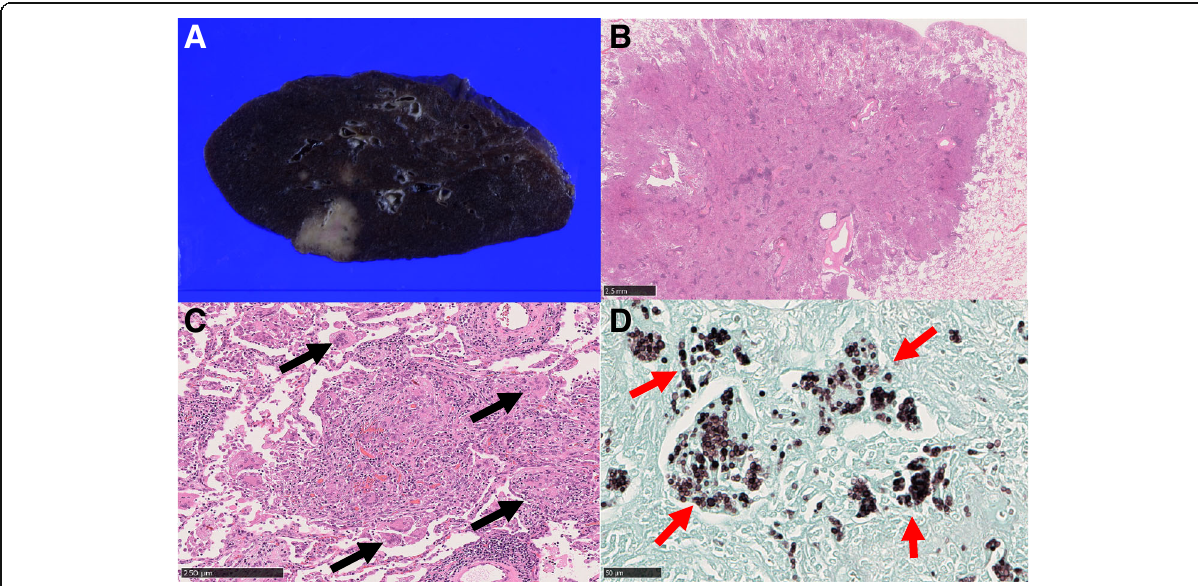
Fig. 2 Pathological findings. a The 24 × 22 × 20 mm mass adjacent to the pleura. b Hematoxylin and eosin (HE) stain × 0.75. The epithelioid granuloma which include vessels and bronchi. c HE stain × 20. There are multinucleated giant cells in the granuloma (black arrows). d Grocott ’ s methenamine silver stain × 40. There are a lot of yeast-like fungi (red arrows) in the cytoplasm of multinucleated giant cells and foam